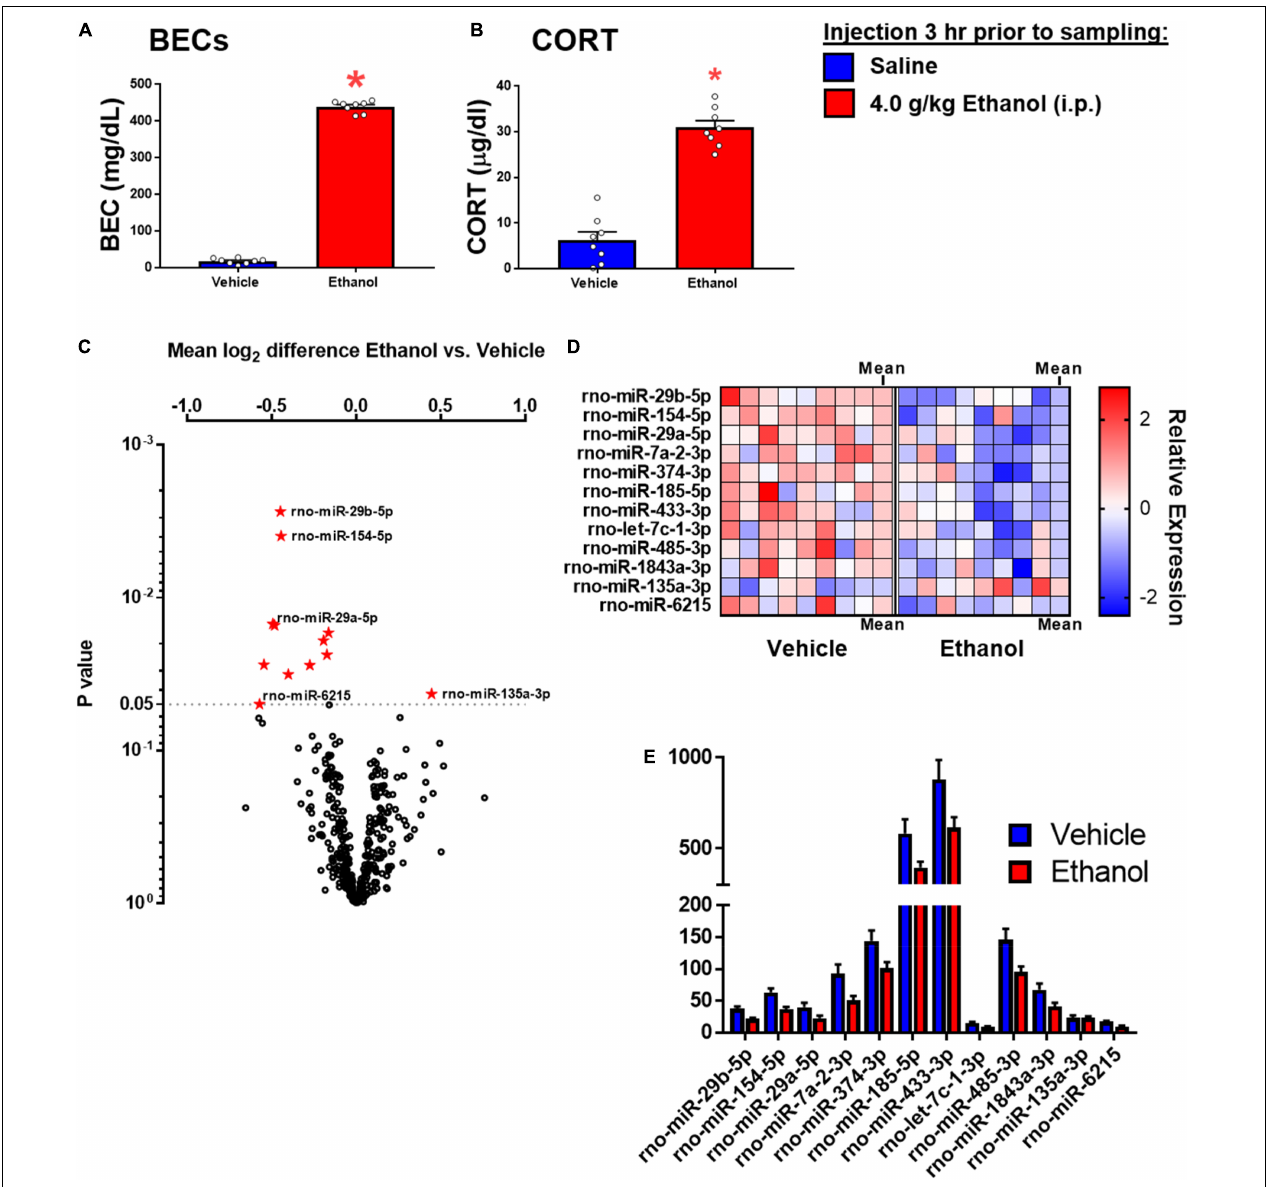
FIGURE 5 | Ethanol-induced miRNA expression in adult males 3 h after ethanol. (A) Blood ethanol concentrations at 3 h after 4 g/kg ethanol, and (B) Plasma corticosterone were both increased. (C) Volcano plot for miRNA expression in the hippocampi of rats given saline or ethanol injection 3 before tissue collection. The miRNA which were significantly affected are shown in panel (D) . (D) A heat map which shows individual sample changes in expression level for miRNA identified in panel (C) , and mean for each group in the last column of each group. (E) Raw expression values for each miRNA significantly affected in panel (A) . Asterisk (*) indicates the effect of ethanol